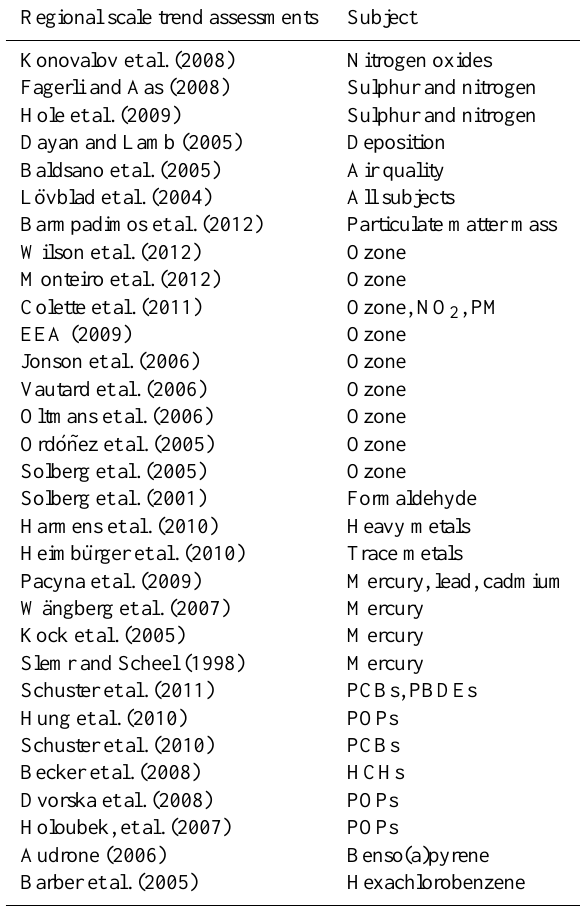
Table 2. Overview of some recent publications that have used EMEP data to assess air pollution trends in Europe. In addition there are a large number of studies which have made assessments based on national networks or individual measurement